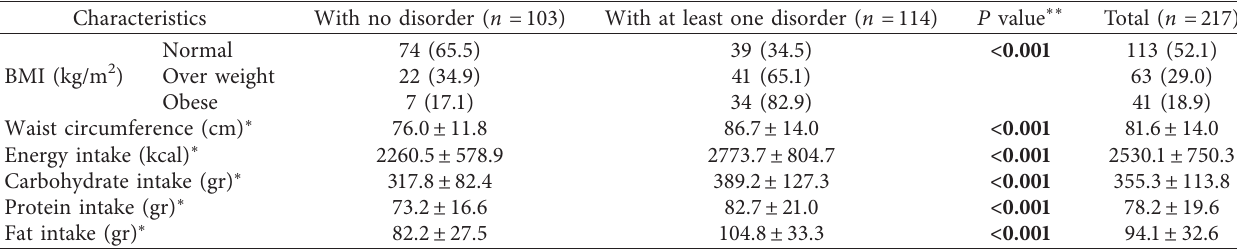
Table 2: The anthropometric indices and macronutrients intake in participants with or without menstrual disorders.